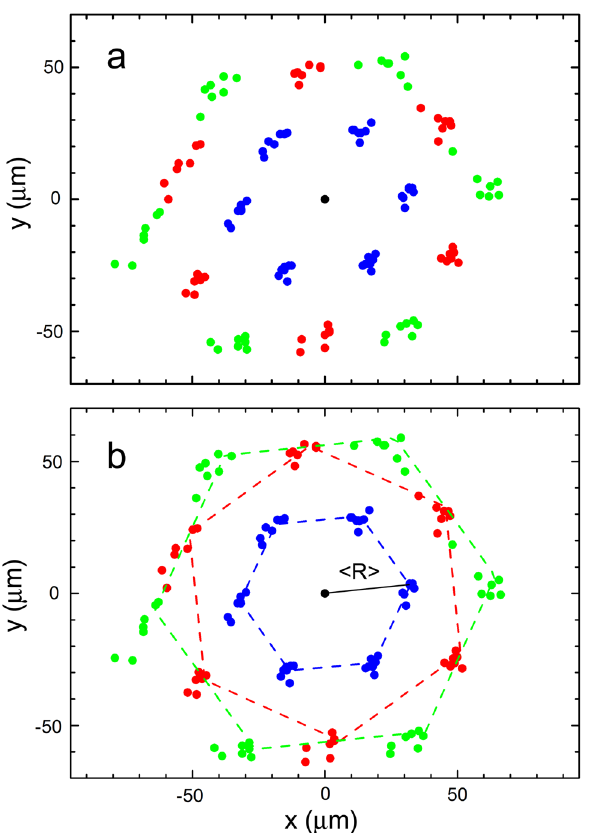
Figure 3. ( a ) Spatial arrangement of droplets in the first three coordination circles determined directly from the image of Fig. 2. Each group of seven dots was obtained for the same directions between droplets. ( b ) Spatial arrangement of droplets corrected to account for image distortion in Fig. 2. Dashed lines show symmetrical hexagons whose vertex coordinates correspond to minimal summary distances from the droplet positions. The R average distance between droplets in the first coordination circle is 32 ± 2 (cid:31) (cid:30)